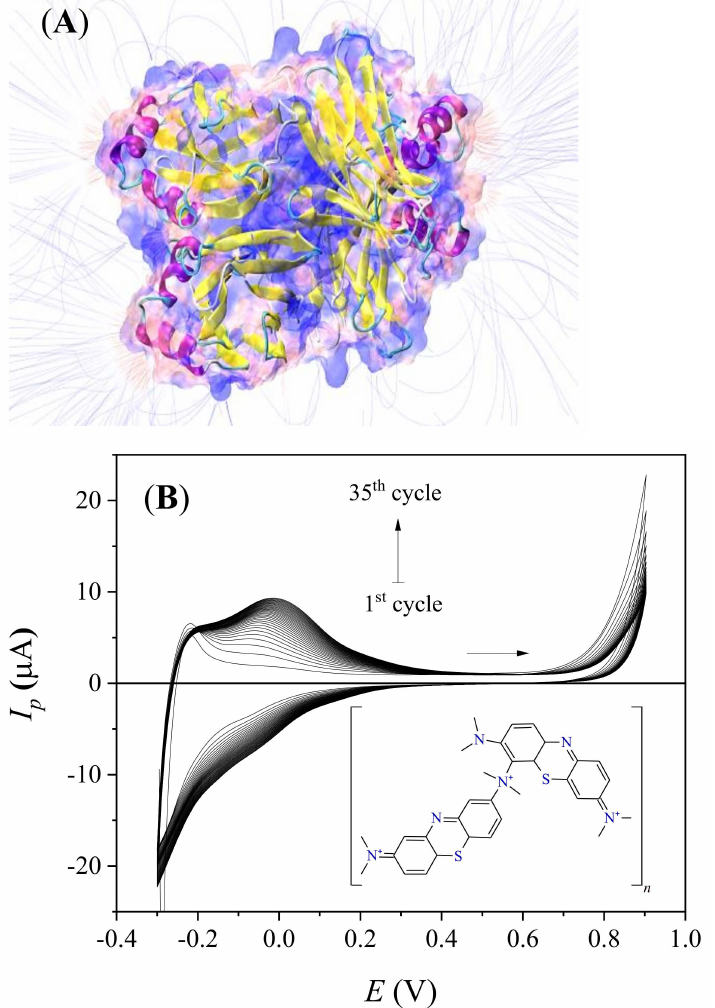
Figure 3. ( A ) ABL three–dimensional projection, highlighting the charge distribution and electric field around the molecule. ( B ) Cyclic voltammograms recorded during poly(methylene blue) elec- trodeposition on fluorine–doped tin oxide–coated glass at 50 mV s − 1 using 100 mmol L − 1 borate buffer (pH = 9.0) as the electrolyte. The insert illustrates the polymer